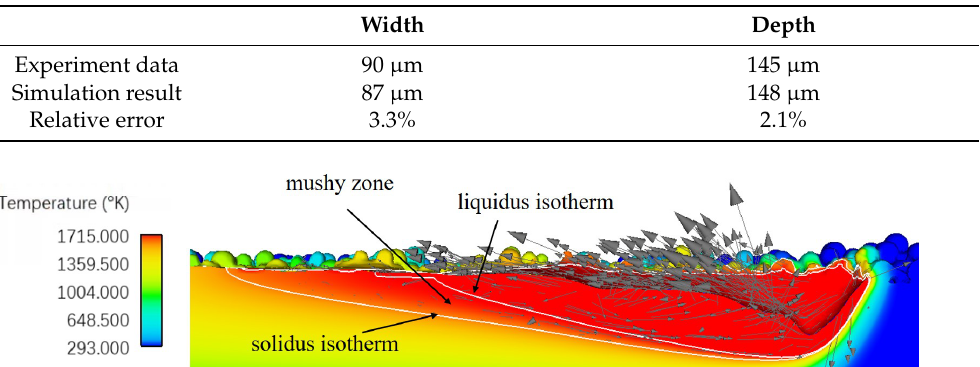
Figure 6. Longitudinal cross-section ( XZ plane) view of a single track simulation result, where the white curves represent the solidus and liquidus isotherms, and the arrows represent the flow field within the melt pool.